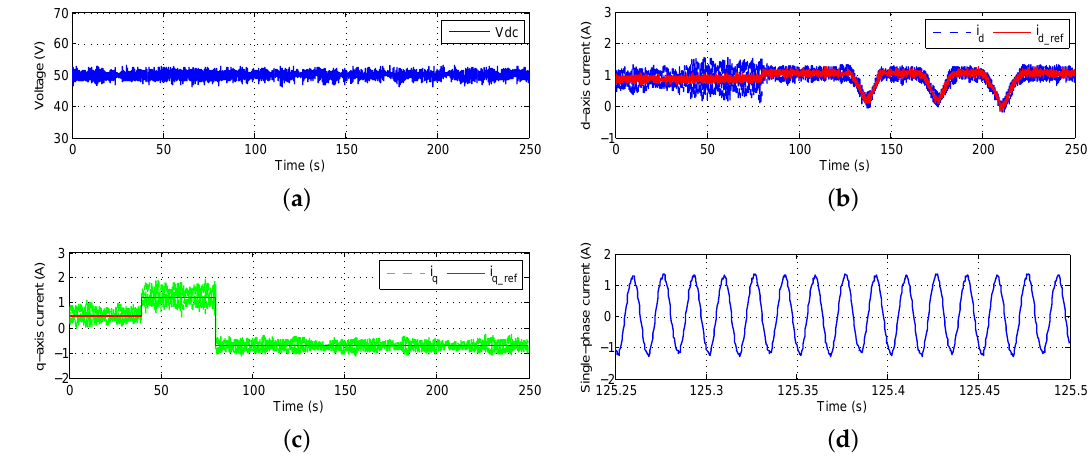
Figure 18. NN vector control for the AC/DC/DC converter with the LC filter. ( a ) DC-link voltage; ( b ) PCC q -axis current waveform; ( c ) PCC q -axis current waveform; ( d ) single-phase current waveform.